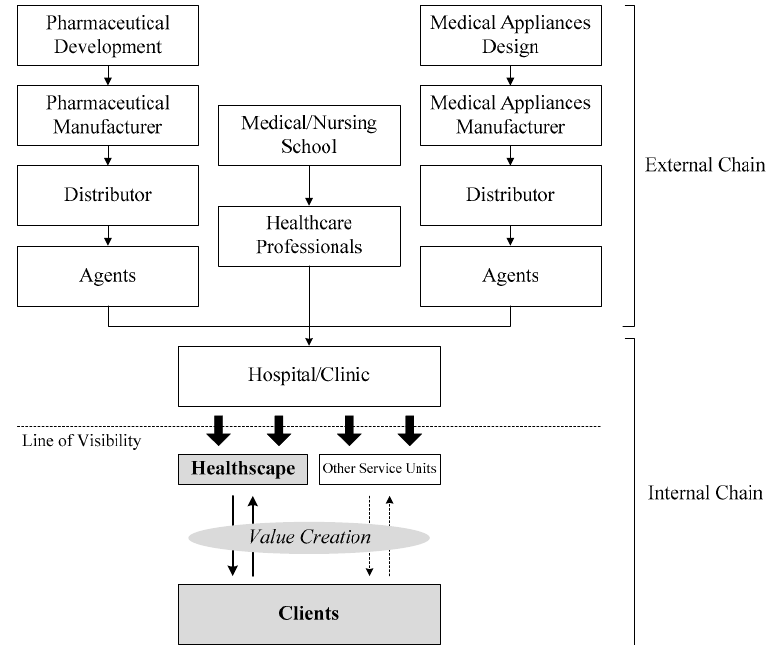
Figure 1. Healthcare supply chain structure.